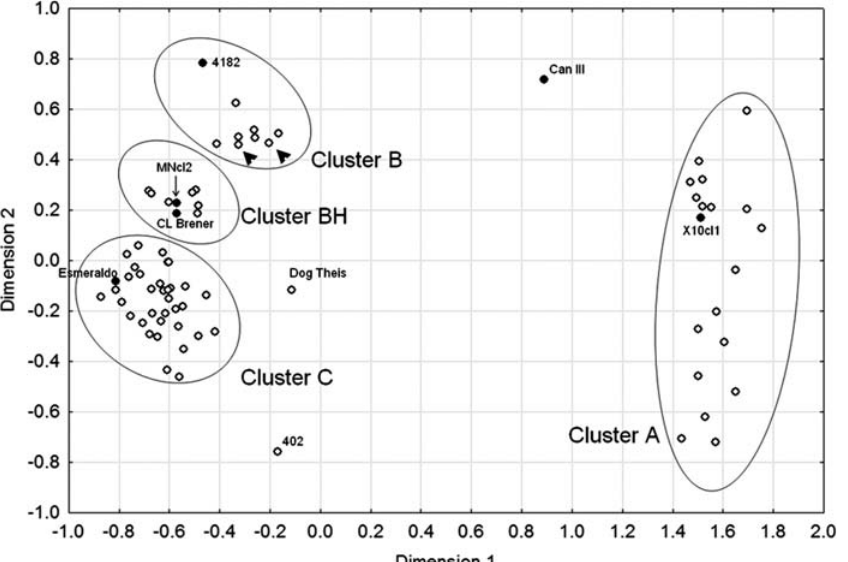
Figure 1. Multidimensional Scaling Plot of 75 T. cruzi Strains Genotyped for Five Microsatellites Only outliers and the prototypical strains of Brisse et al. [26] are named in the plot. Arrowheads indicate strains 222 and 115. The strains in the areas delimited by ellipsoids are the following: MDS-cluster A: 1001, 1004, 1006, 1502, 1523, A83, A87, Col18/05, Colombiana, Cuı´ca, Cutia, D7, Gambacl1, Rb1, Rb2, Rb6, SE, X10cl1, 402, Mas1cl1, 84, 207, 209, 239, 577, 578, 580, 581, 803, 1005, 1014, 1043, 1931, 183744, 169/1; MDS-cluster C: 200pm, 84Ti, Be62, CPI11/94, CPI95/94, Esmeraldo, Gil, GLT564, GLT593, GMS, GOCH, Ig539, JAF, JG, JHF, JSM, MPD, OPS27/94, Tu18 cl11, Y; MDS-cluster B: 115, 222, 226, 231, 3663, 3869, 4182, M5631cl5; MDS-cluster BH: M6241cl6, 167, 1022, c182, CLBrener, MNcl2, NR, SC43 cl1, SO3, Tulacl2. DOI: 10.1371/journal.ppat.0020024.g001 PLoS Pathogens |